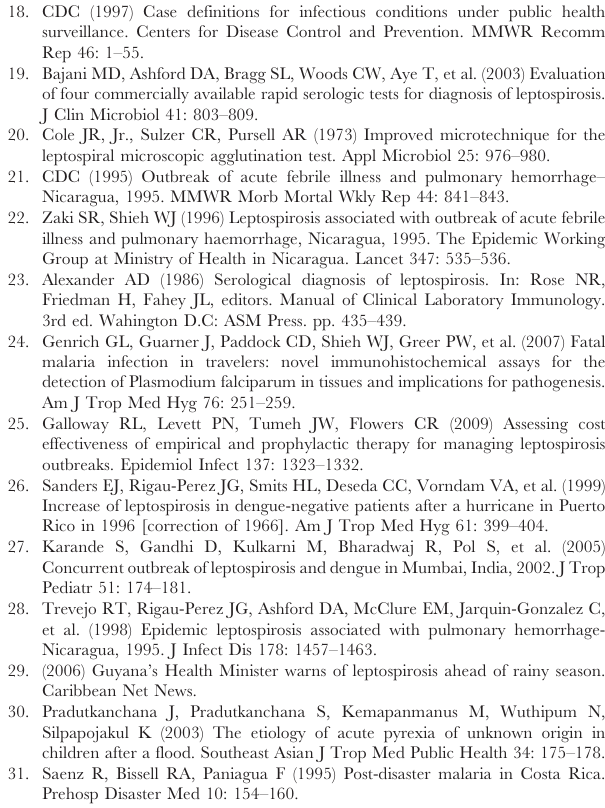
Figure S1 Cases: Gray: Suspected; Grid Pattern: Probable; Black: Confirmed (TIF) Table S1 Symptoms, signs, and laboratory results of hospitalized leptospirosis patients, Guyana, January 26–February 21, 2005.